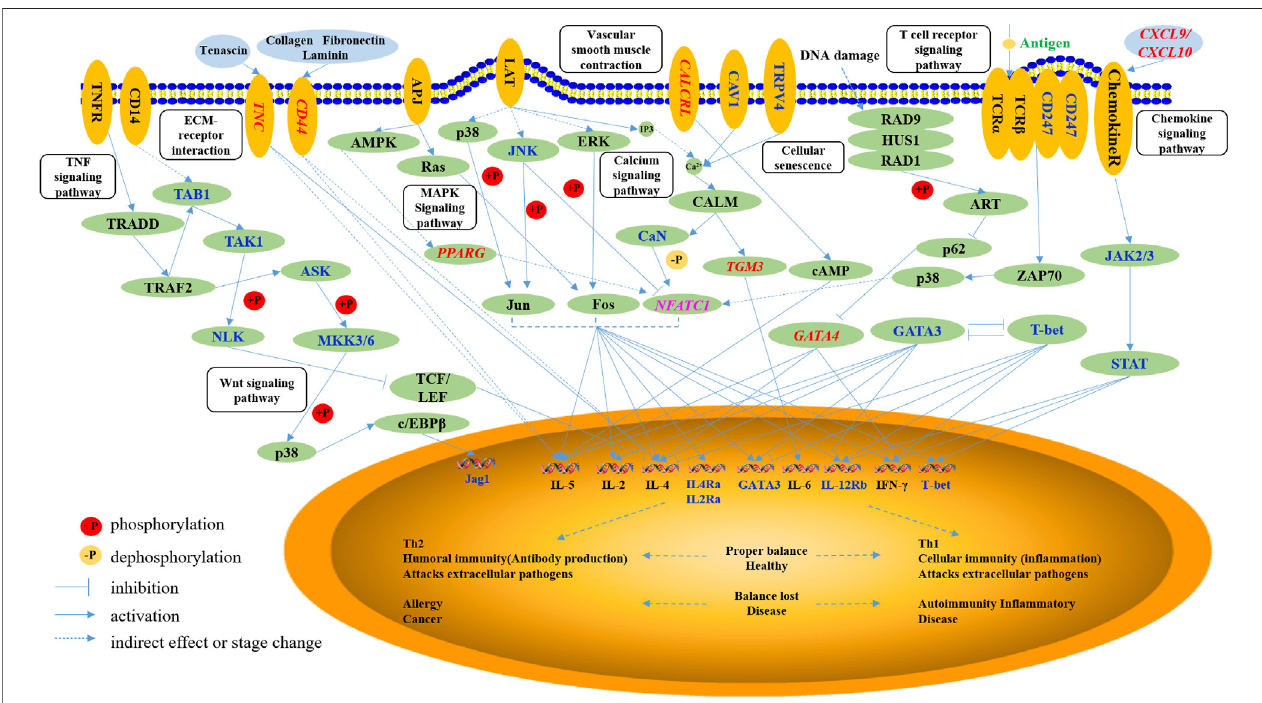
FIGURE 4 | The networks of the immune-related pathways to paratuberculosis. The oval with non-italic characters represents the protein, the oval with italic characters represents the gene, and the small circle represents the small molecule. Orange ellipses are the membrane proteins, the blue ellipses are the extracellular matrix, and green ellipses are the intracellular matrix. Blue and pink characters are the differentially methylated genes, and the red characters are the genes with differential methylation and